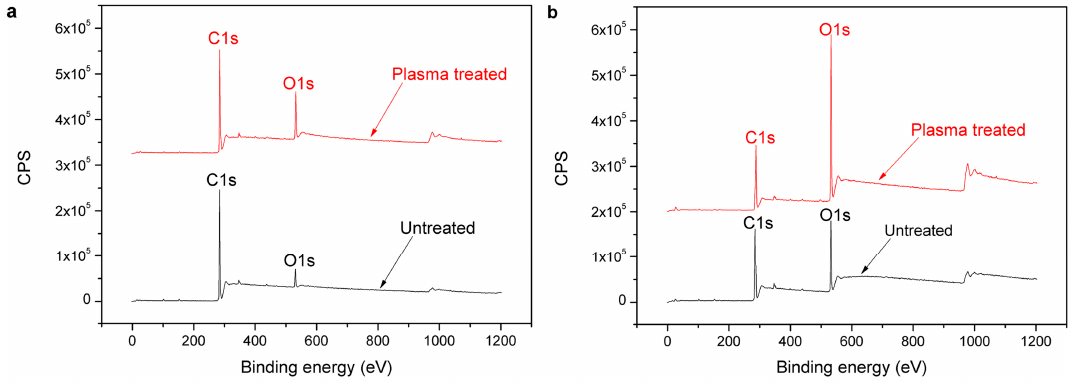
Figure 9. XPS (X-ray photoelectron spectroscopy) spectra of polymer surface: ( a ) PE; ( b ) POM. Table 4. Element content of PE and POM before and after plasma treatment.